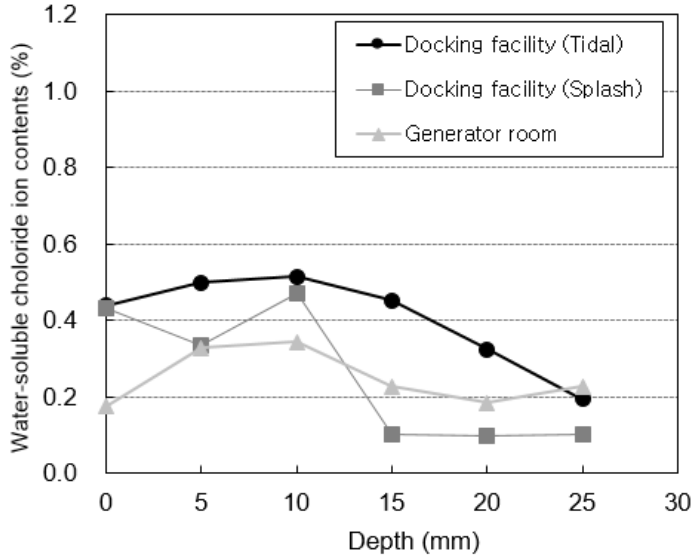
Figure 7. Chloride-ion content at atmospheric pressure.